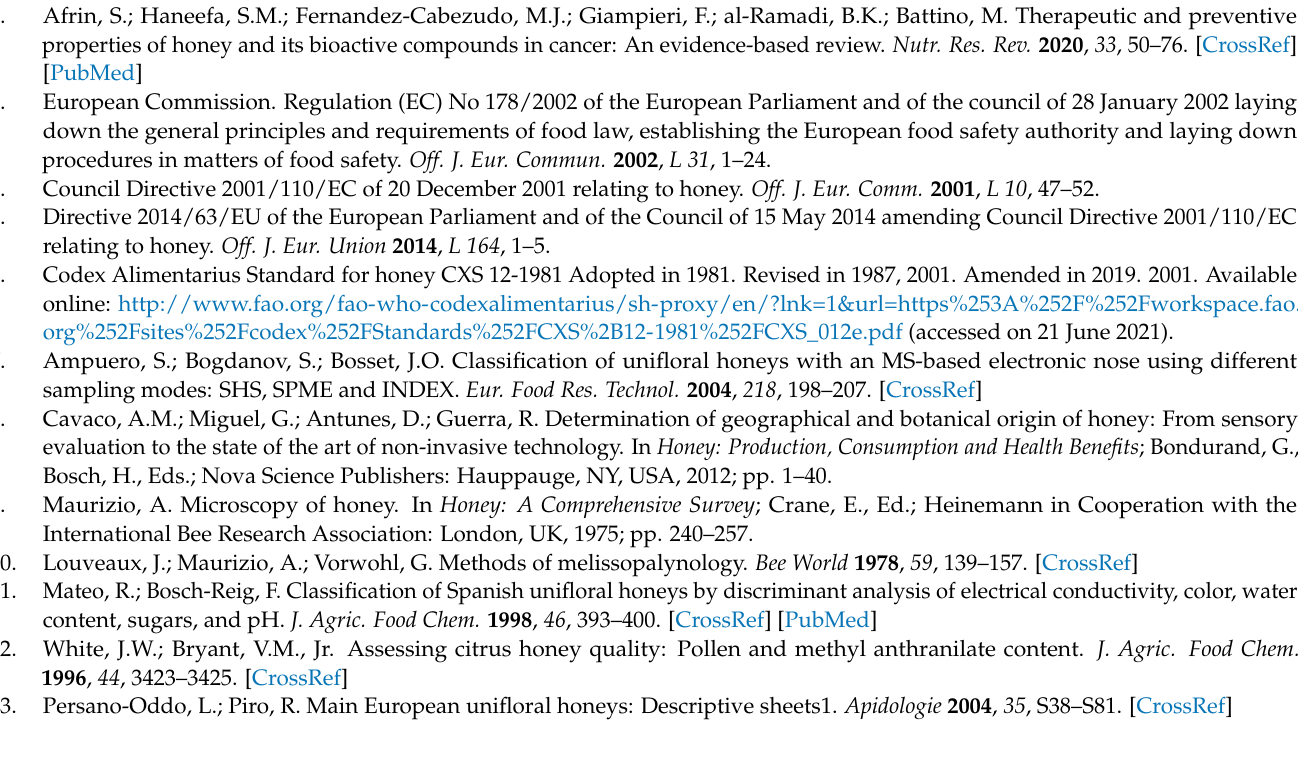
variable is not included in the dataset), Figure S3: Clustering of the honey dataset in 7 clusters by k-means. The largest symbols correspond to the centroids of each cluster, Figure S4: Plot of the importance of the variables from the honey dataset, as estimated by an RF model, Figure S5: Box plots of metric values of several ML algorithms by optimization throughout training with 10-fold cross-validation of the honey dataset with splitting into training and test sets obtained in three additional repetitions: (a), (b) and (c) log loss of repetitions 2, 3 and 4; (d), (e) and (f) accuracy and kappa of repetitions 2, 3 and 4. Black circles symbolize mean values, Figure S6: Box plots of (a) log loss, (b) accuracy and kappa values of several ML algorithms throughout the training with 10-fold cross-validation of the honey dataset without partitioning into training and test sets. Black circles symbolize mean values, Table S1: Mean values for the predictor variables in the two clusters obtained by k-means, Table S2: Confusion matrices obtained with all honeys in the dataset without splitting into training and test sets using 10-fold